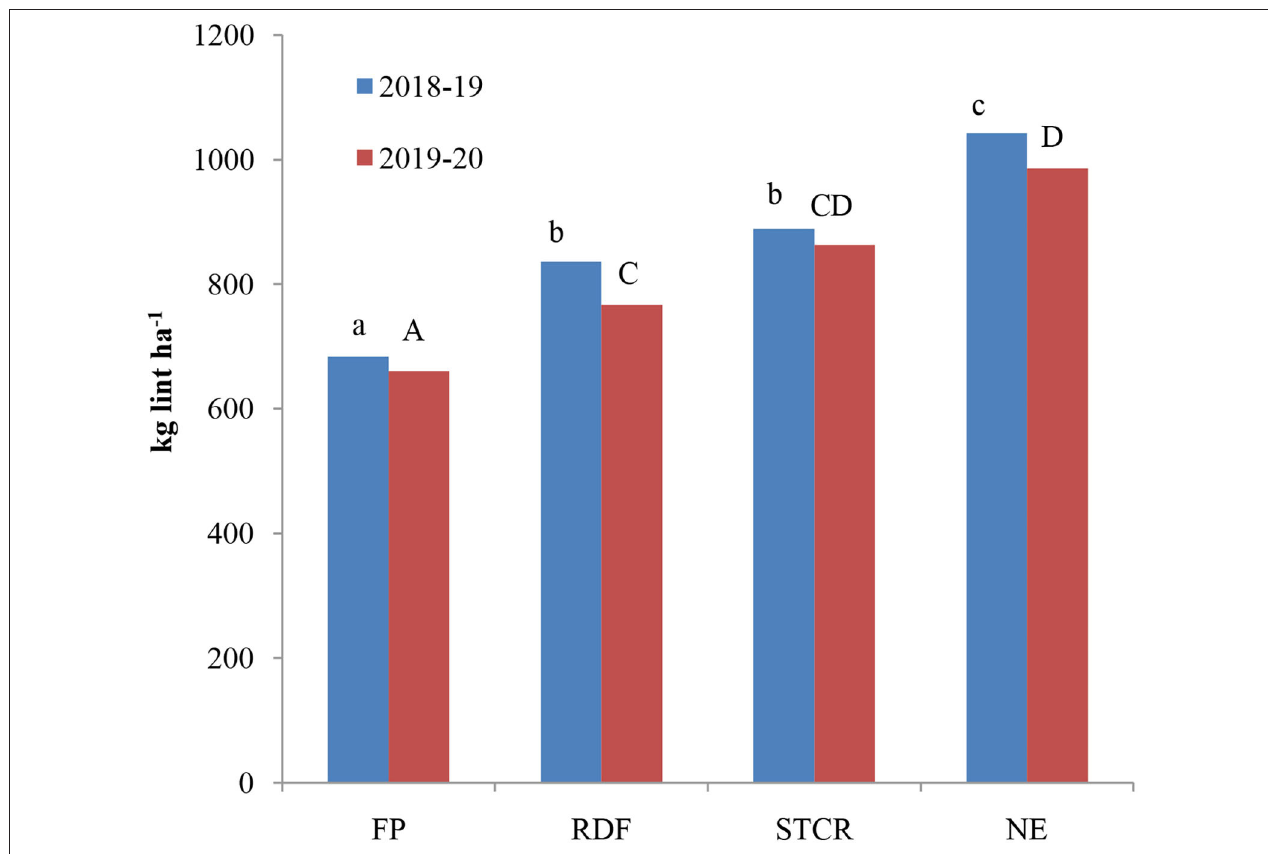
FIGURE 2 | Lint yield (kg ha − 1 ) as affected by nutrient management practices over years averaged across locations (columns with similar letter are not statistically significant; small case letters for 2018–2019 and capital letters for